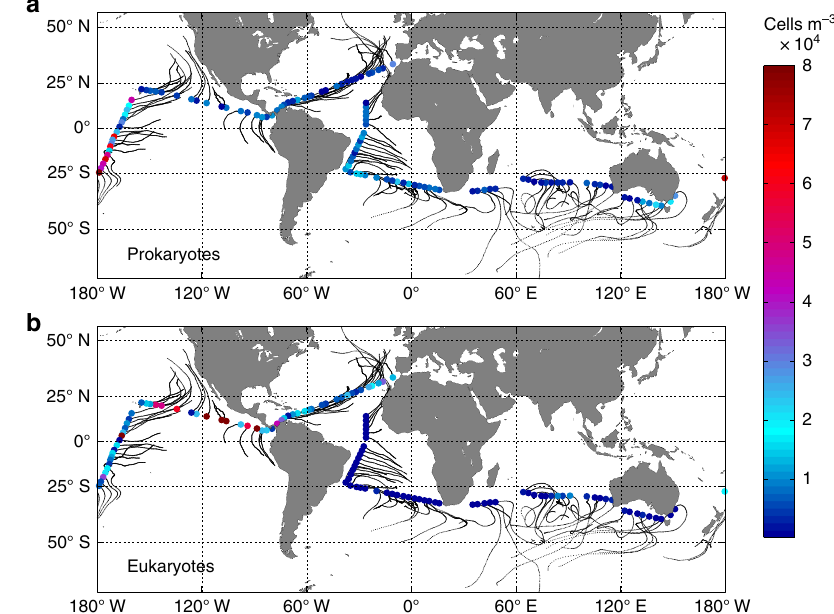
Figure 1 Abundances of airborne microbes over the ocean. Airborne prokaryotic a and eukaryotic abundances b over the Malaspina 2010 Circumnavigation Expedition. Dots correspond to sampled locations and black lines correspond to backward trajectories of air masses modelled for 5 days previous to the air sampling starting at 10 m above sea level NATURE COMMUNICATIONS | 8: 201 | DOI: 10.1038/s41467-017-00110-9 |